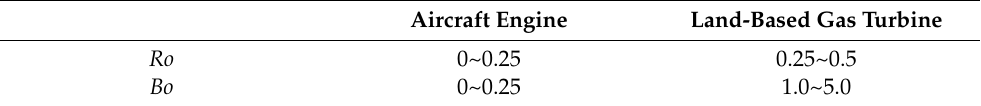
Figure 1. The Bo ranges of gas turbine and aircraft engine under typical operating conditions. Table 1. Typical Ro and Bo of aircraft engine and land-based gas turbine [1].